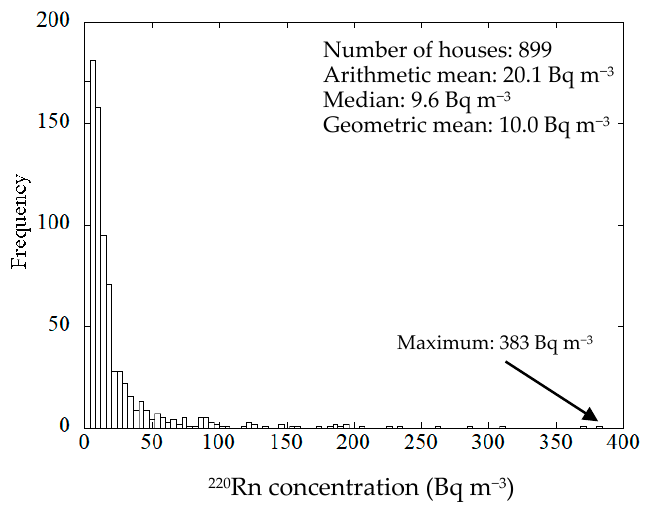
Figure 1. Histogram for indoor 220 Rn concentrations.